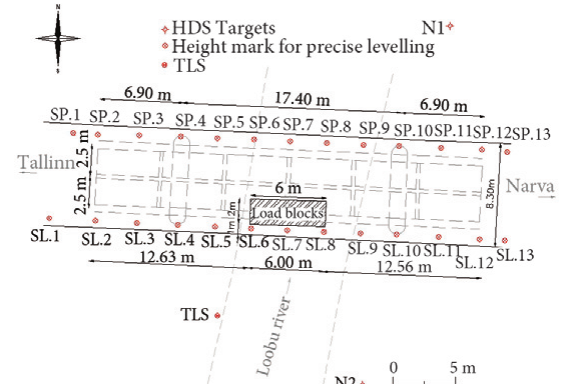
Fig. 5. Locations of the levelling height marks, TLS station, HDS targets and the load blocks. The bridge columns and cantilever beams with beam supports are exhibited by dashed lines